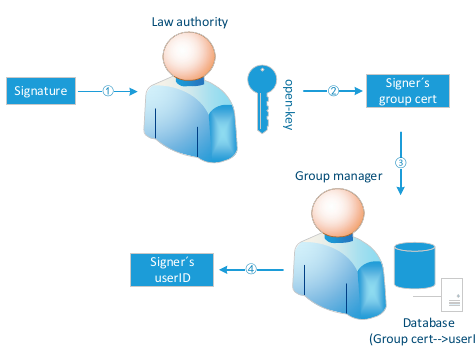
Figure 8. Accountability procedure in APAC model .